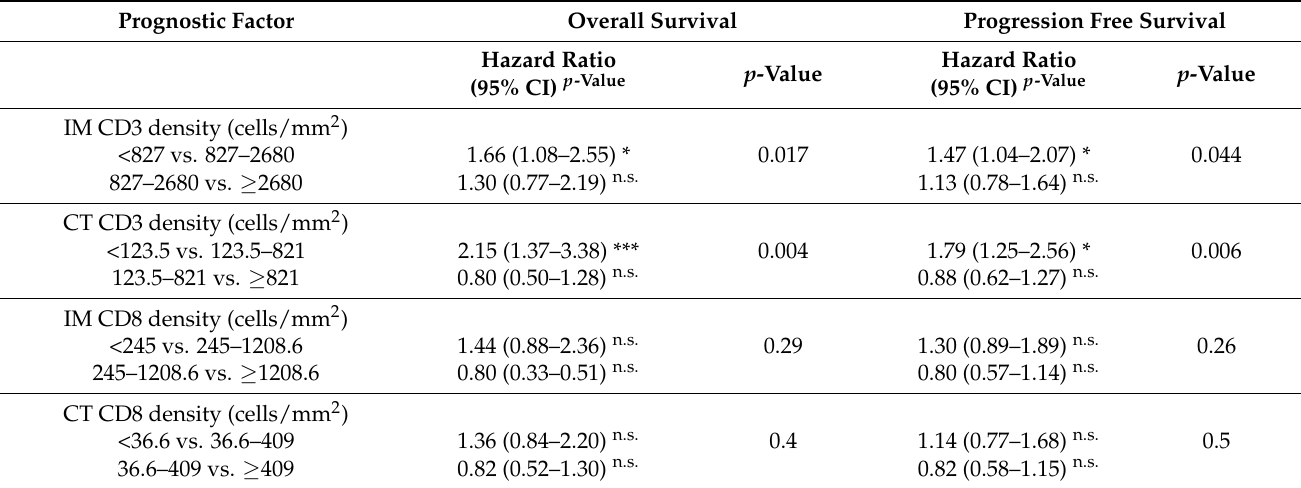
Table 2. Multivariate analysis of the prognostic impact of CD3 + and CD8 + T-cell density at the invasive margin and center of the tumor for overall survival and progression free